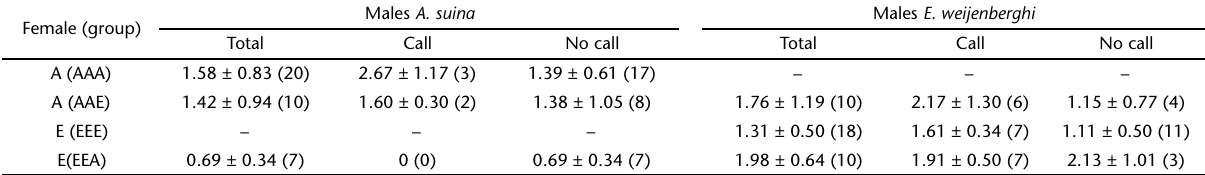
Table II. Frequencies of bouts of body vibration (bouts per minute) performed by males during the first five minutes of courtship in the experimental groups (E = E. weijenberghi ; A = A. suina ). Data are presented as mean ± standard deviation and data number between parentheses. We discriminate between the frequencies of body vibration which determined female call and those which did not. (In EEE two males did not perform body vibration and in EEA three males A. suina did not perform body vibration). Males A. Female (group)